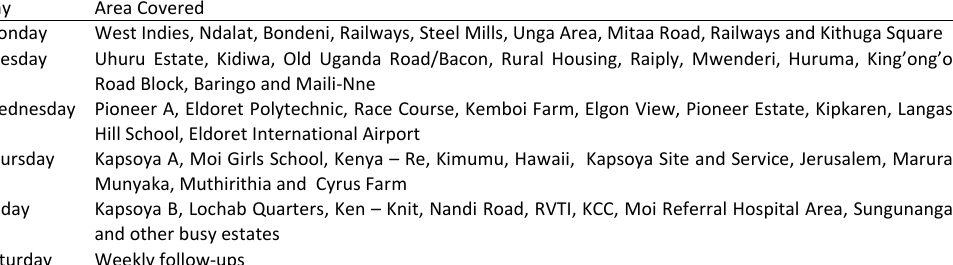
Table 5: The solid waste collection programme (The Director of Environment and Enforcement, 2018)